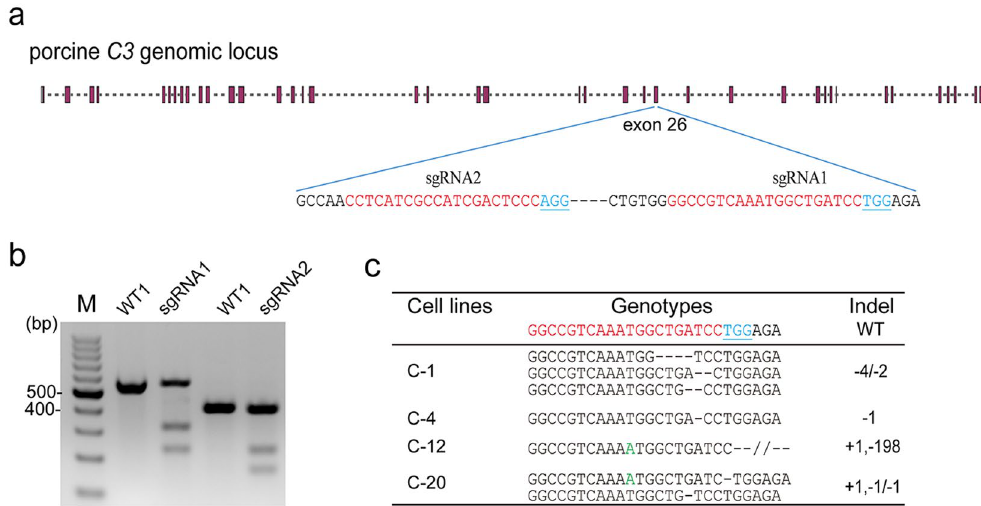
Figure 1. CRISPR/Cas9-mediated C3 gene targeting in PFFs. ( a ) Schematic diagram of sgRNA targeting the exon 26 of the C3 gene. sgRNA targeting sites are highlighted in red. PAM sequences are underlined and highlighted in blue. ( b ) T7E1 assay for CRISPR/Cas9-mediated cleavage at target site in PFFs. WT1 and WT2: PCR products of untransfected PFFs treated with T7E1; sgRNA1 and sgRNA2: PCR products of PFFs transfected with Cas9-sgRNA1 and Cas9-sgRNA2 treated with T7E1. ( c ) Biallelic mutation donor cell sequences for SCNT. The wild-type sequence is shown at the top of the target sequence. The sgRNA sequences are highlighted in red, PAM sequences in blue, and insertions in green; deletion ( − ); insertion ( + ).